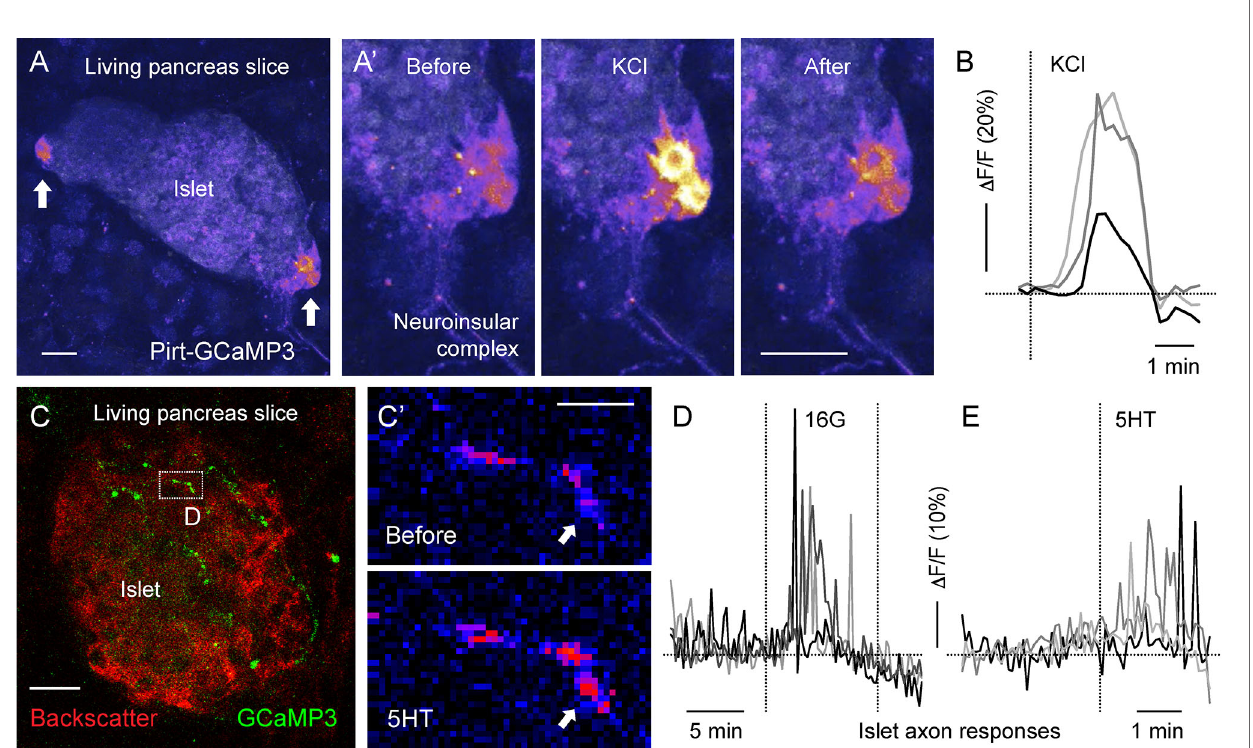
FIGURE 4 | Living mouse pancreatic slices for imaging Ca 2+ activity in neuroinsular ganglia and in sensory axonal terminals [photomicrographs are from experiments conducted by Dr. Jonathan Weitz, (A, B) unpublished data, (C – F) adapted and modi fi ed from Figure 6 in Makhmutova et al, 2020]. (A, C) Z-stacks of confocal images of living pancreatic slices from Pirt-GCaMP3 mice. (A) A representative islet containing neuroinsular ganglia ( arrows ), with GCaMP3 fl uorescence and islet backscatter shown in pseudocolor scale; scale bar 10 µm. (A ’ ) Sequential images of the neuroinsular ganglion shown in A, displaying a Ca 2+ response to KCl (25 mM). (B) Representative traces of mean fl uorescence intensity changes over baseline ( d F/F) in the neuroinsular ganglion shown in (A ’ ) , demonstrating neuronal responses to KCl stimulation. (C) Representative islet containing GCaMP3-expressing sensory axonal terminals (green). Islet backscatter is shown in red; scale bar 20 µm. (C ’ ) Sequential images of the sensory fi ber shown in C (box), displaying a Ca 2+ response to 5-HT (50 µM). The arrow points to a region showing an increase in GCaMP3 fl uorescence (pseudocolor scale); scale bar 5 µm. (D, E) Representative traces of mean fl uorescence intensity changes over baseline ( d F/F) in sensory fi bers, demonstrating responses to an increase in glucose concentration from 3 mM to 16 mM (16G, D ) and to 5-HT (50 µM) stimulation (E)